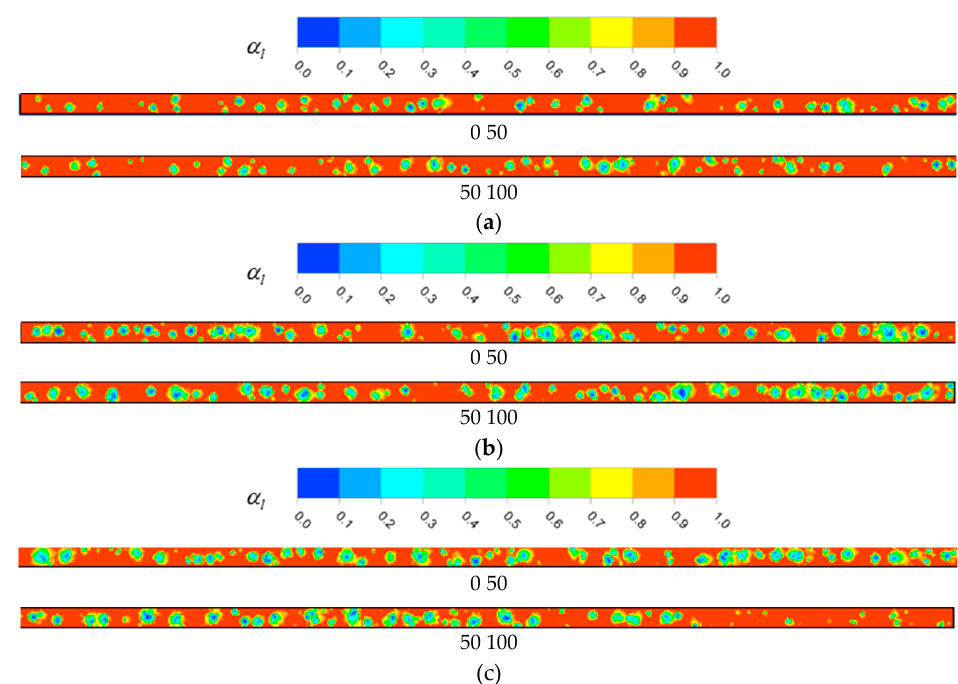
Figure 7. Volume fraction distribution of az-refrigerant liquid phase at different mass fluxes: ( a ) T sat = 253 K, G = 50 kg/m 2 s, q = 10 kW, X = 0.26; ( b ) T sat = 253 K, G = 75 kg/m 2 s, q = 10 kW, X = 0.18; ( c ) T sat = 253 K, G = 100 kg/m 2 s, q = 10 kW, X = 0.13.